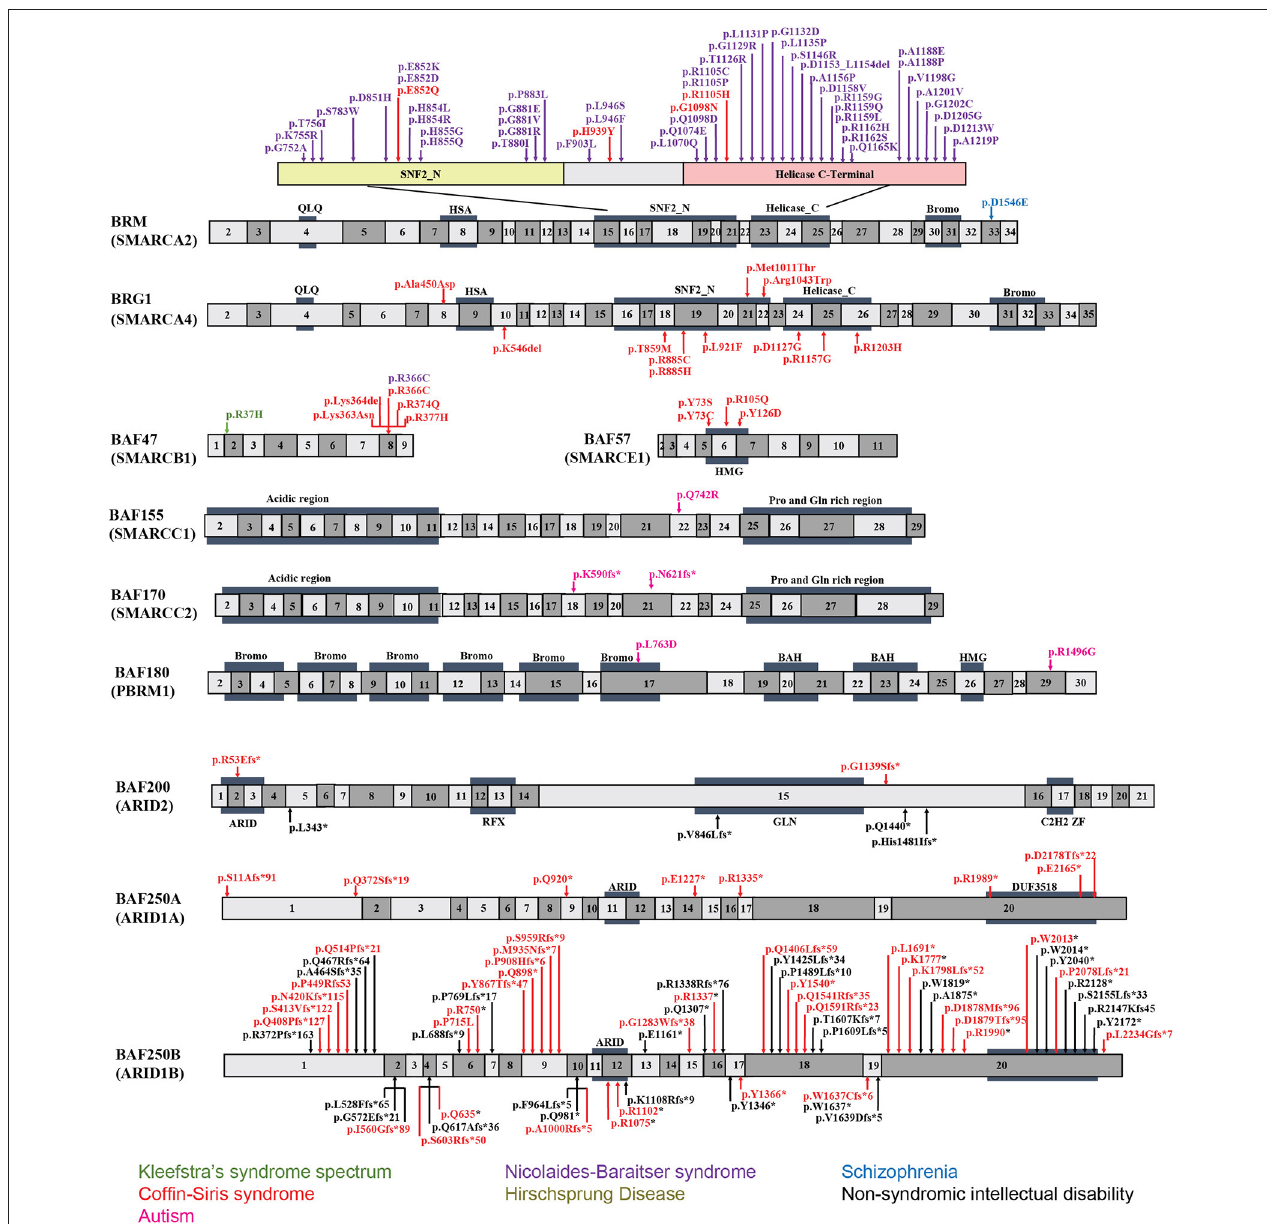
FIGURE 2 | Exon-structure of the genes encoding for BAF subunits and sites of the pathogenic mutations in neurodevelopmental disorders. The specific functional domains are also shown: ARID, A-T rich interaction domain; QLQ, Gln, Leu, Gln motif; HSA, small helicase/SANT-associated domain; SNF, sucrose/non-fermenting domain; BROMO, bromodomain; HMG, high-mobility group domain; RFX, RFX-like DNA binding domain; C2H2 ZF, C2H2 zinc fingers.